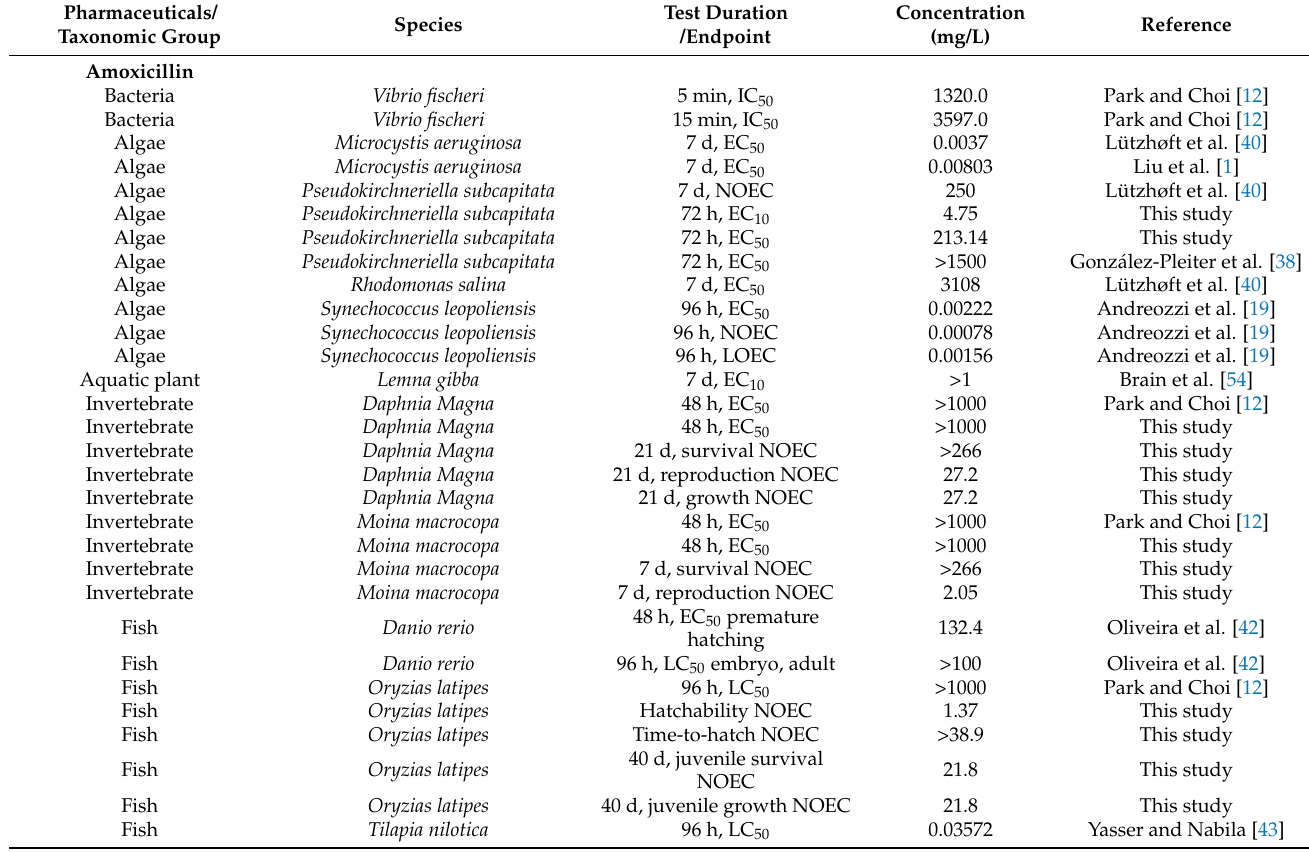
Table 1. Ecotoxicity of tested pharmaceuticals on aquatic organisms obtained from the present study and from the literature. Pharmaceuticals/ Taxonomic Group